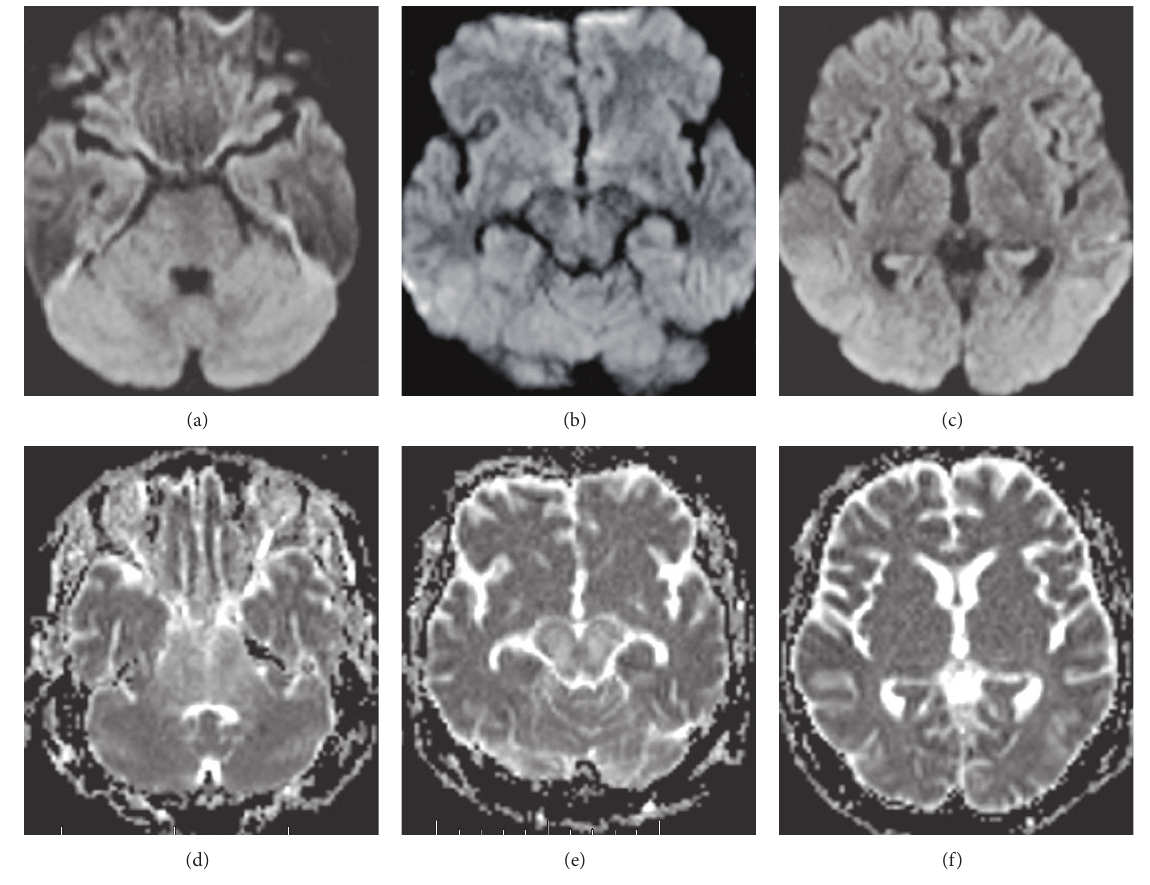
Figure 3: Magnetic resonance imaging (MRI) diffusion-weighted images (DWI): axial images ((a)–(c)) showing no restricted diffusion, and ADC map images ((d)–(f)) with increased apparent diffusion coefficient in the brain